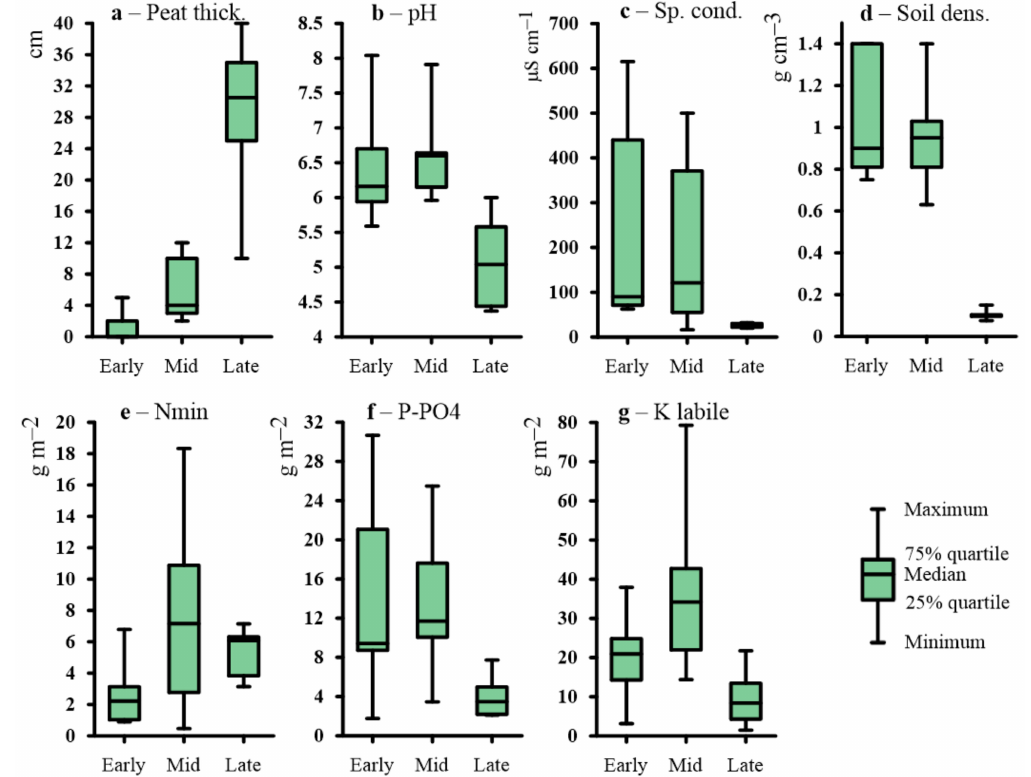
Figure 2. Analytical properties in a soil layer of 0–30 cm through three successive stages of khasyreys. ( a )—peat thickness; ( b )—soil water pH; ( c )—specific electrical conductivity; ( d )—soil density; ( e )—mineral forms of nitrogen (N-NO 3 − + N-NH 4 + ); ( f )—labile phosphorus pool in 0–30 cm layer; ( g )—labile potassium pool in the 0–30 cm